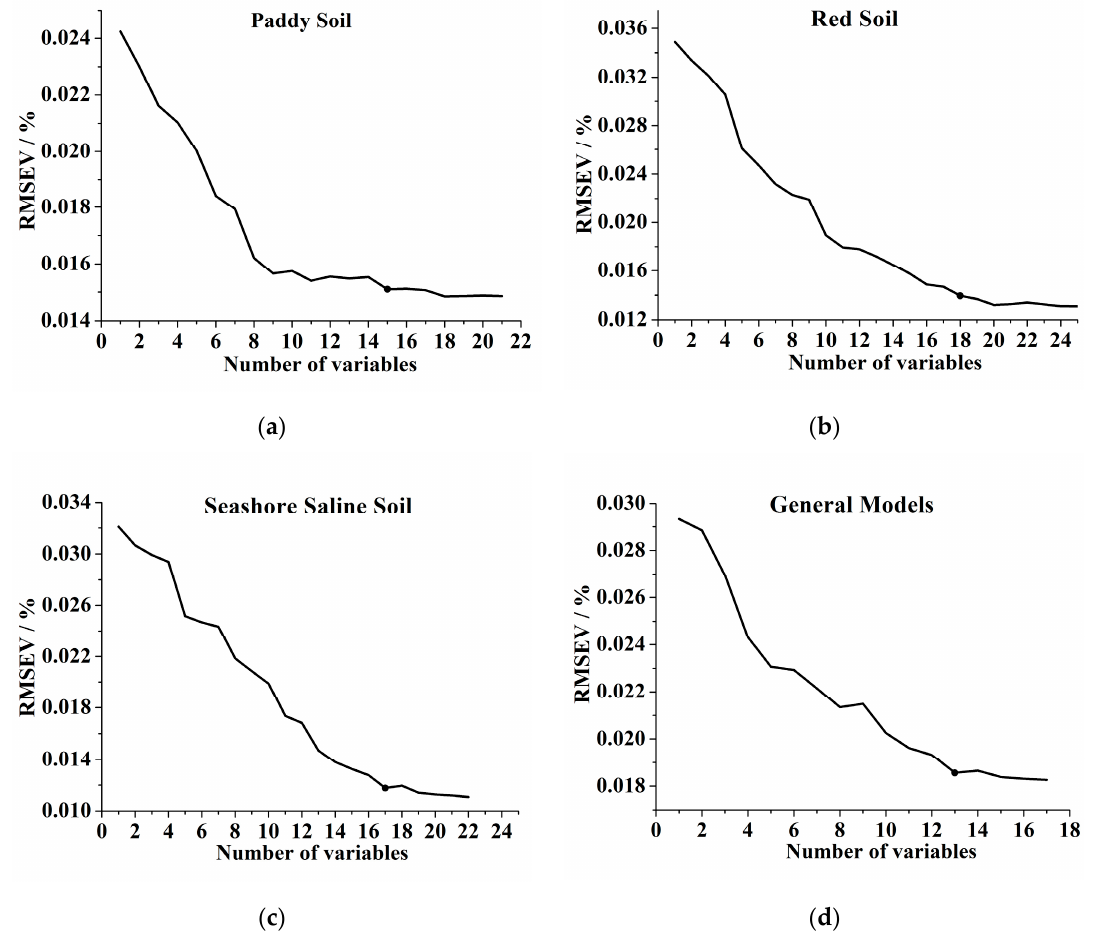
Figure 7. RMSECV curves with the number of variables selected by SPA for ( a ) paddy soil, ( b ) red soil, ( c ) seashore saline soil and ( d ) general models. The reference data in SPA was soil TN content.